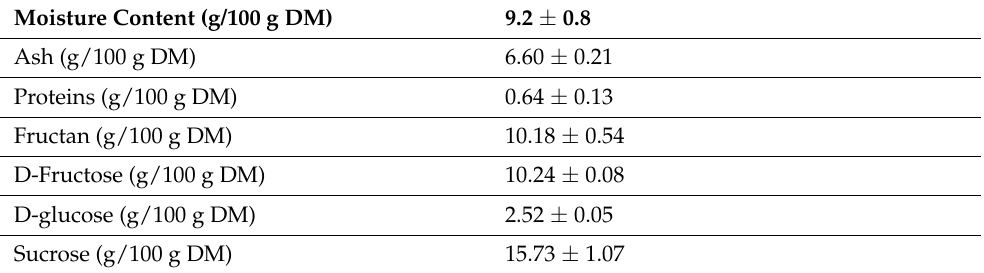
Table 2. Forced chicory root (FCR) characterization.